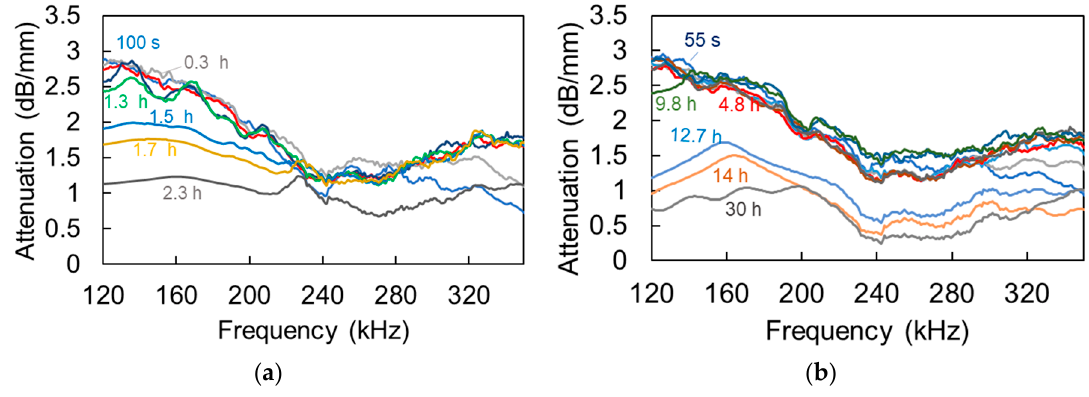
Figure 11. Attenuation vs. frequency curves at different ages ( a ) for reference mortar and ( b ) for mortar with SAPs.